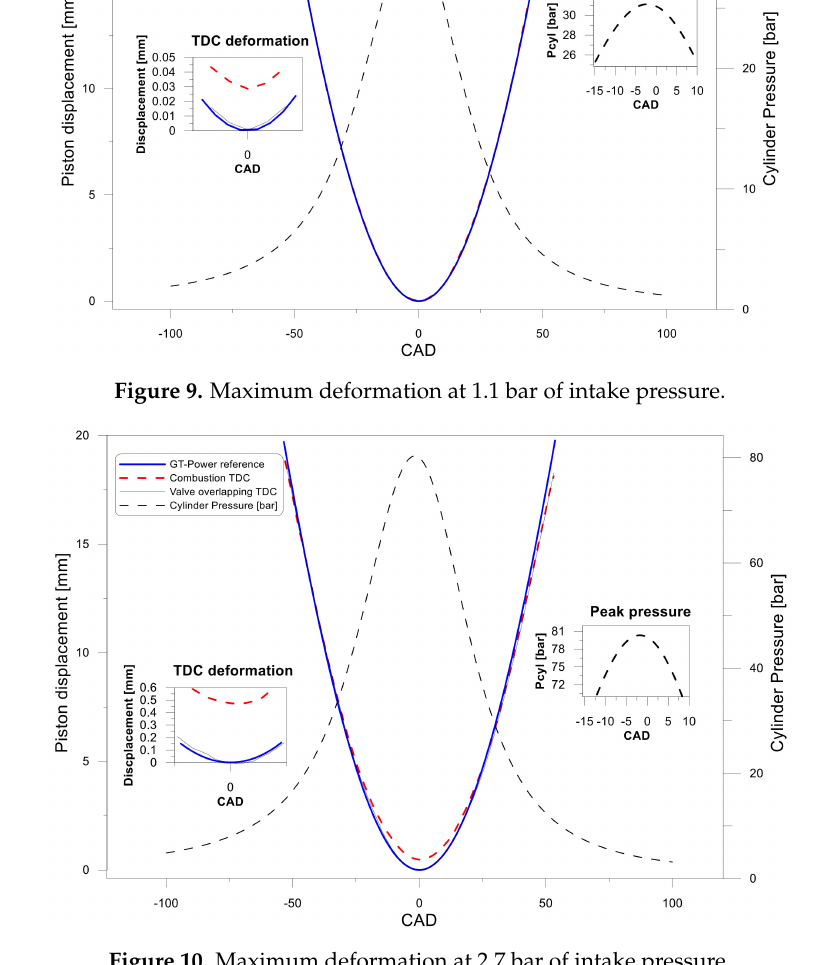
Figure 10. Maximum deformation at 2.7 bar of intake